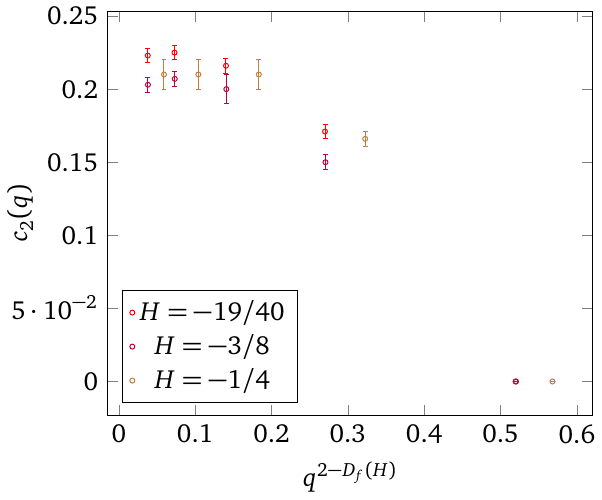
( q ) in the range H > − 1 / 2